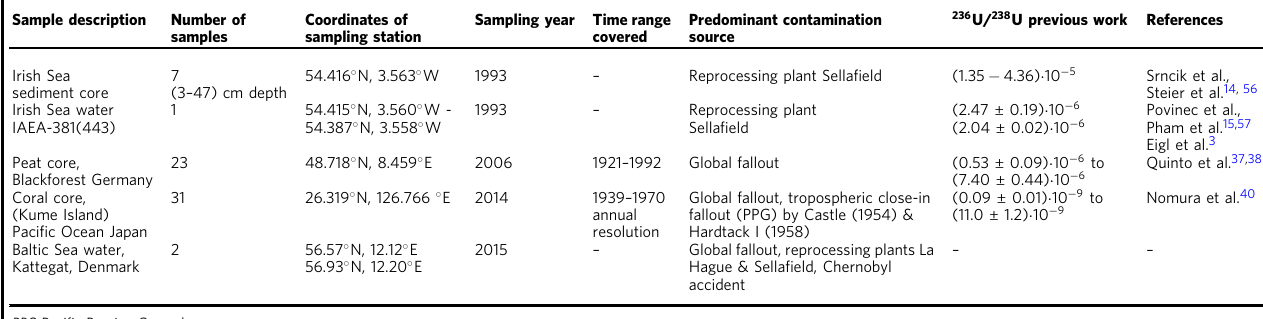
Table 1 Overview of the sample material used in the present study for 233 U/ 236 U